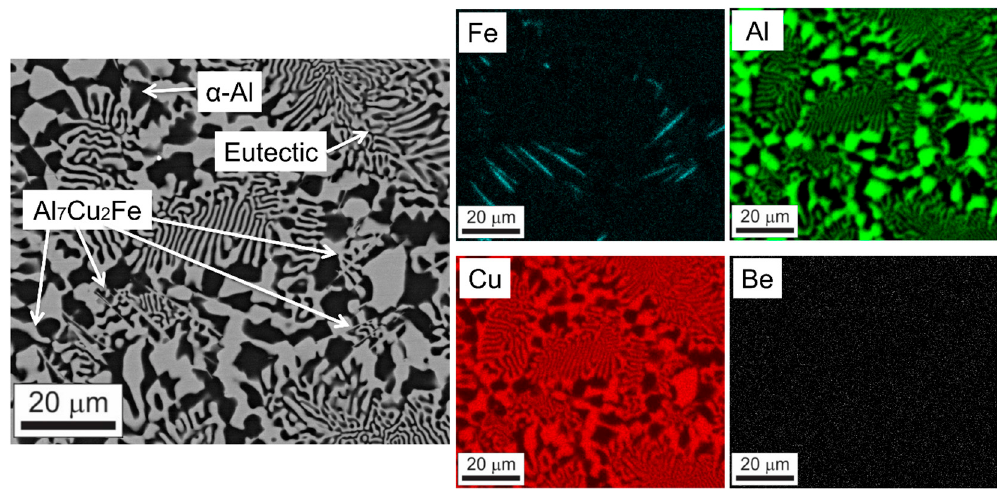
Figure 12. SEM image with EDS mapping detailing the phases present in the Al-33 wt.%Cu-0.05 wt.%Be alloy.